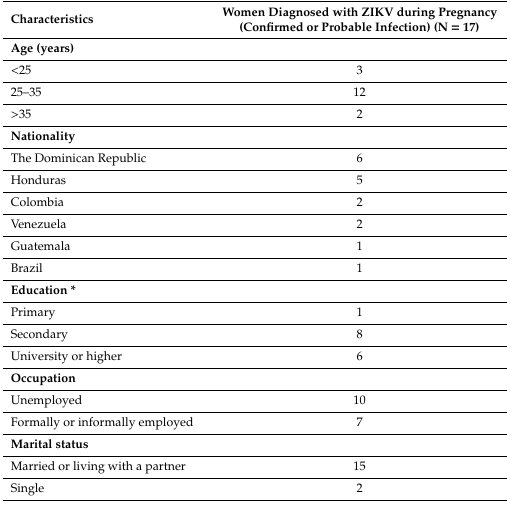
Table 1. Demographic characteristics of women participating in the